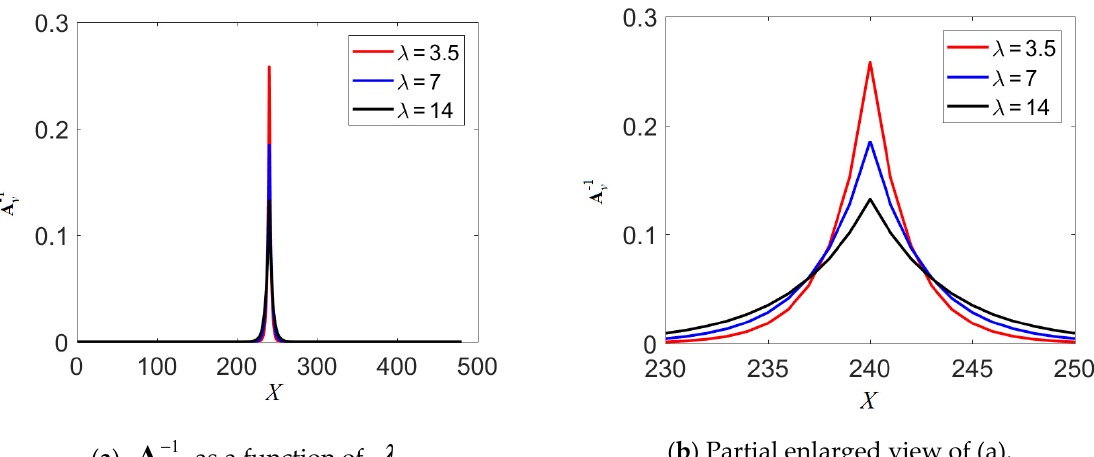
− A λ 1 Figure 4. A − 1 v as a function of λ . The image size is 480-by-720. The plots show the element values of Figure 4. as a function of . The image size is 480-by-720. The plots show the element values v A − 1 v on row 240. ( a ) The value of A − 1 v for different λ values. ( b ) Partial enlargement of ( a − A 1 -1 A for different λ values. ( b ) Partial enlargement of ( a ). of on row 240. ( a ) The value of v v